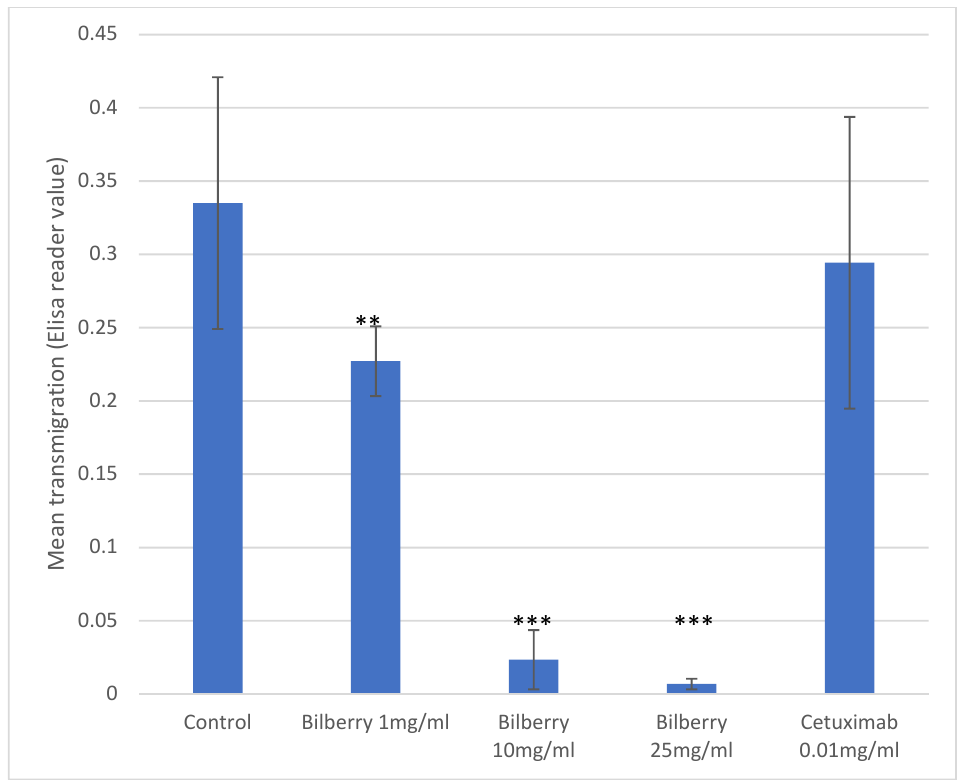
Figure 2. Transmigration of HSC-3 cells. Statistical test between control and different bilberry concentrations and cetuximab: ** p < 0.01; *** p < 0.001; 95%CI error bars.